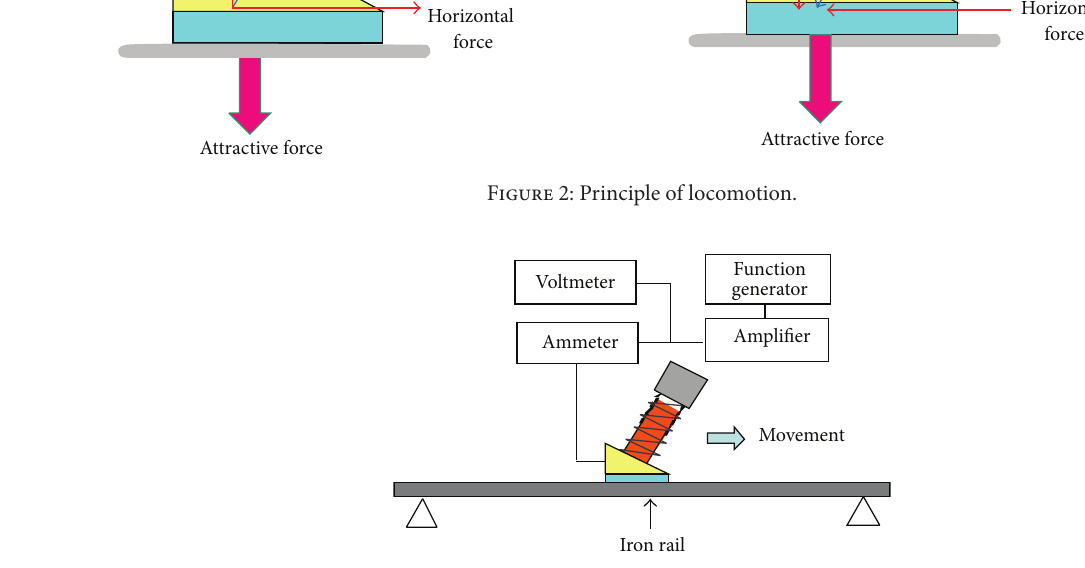
Figure 3: Experimental apparatus.